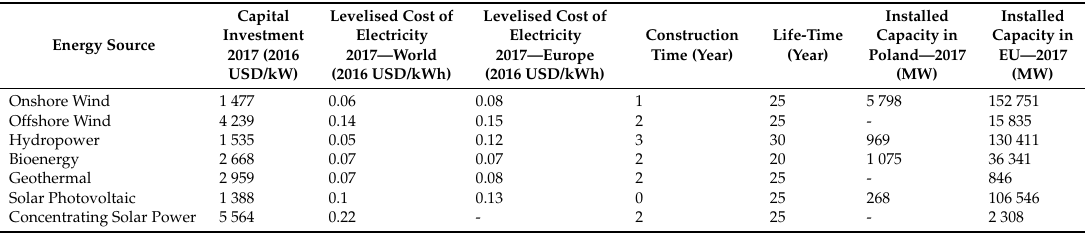
Table 1. Comparison of basic RES technologies with regard to necessary investment and installed